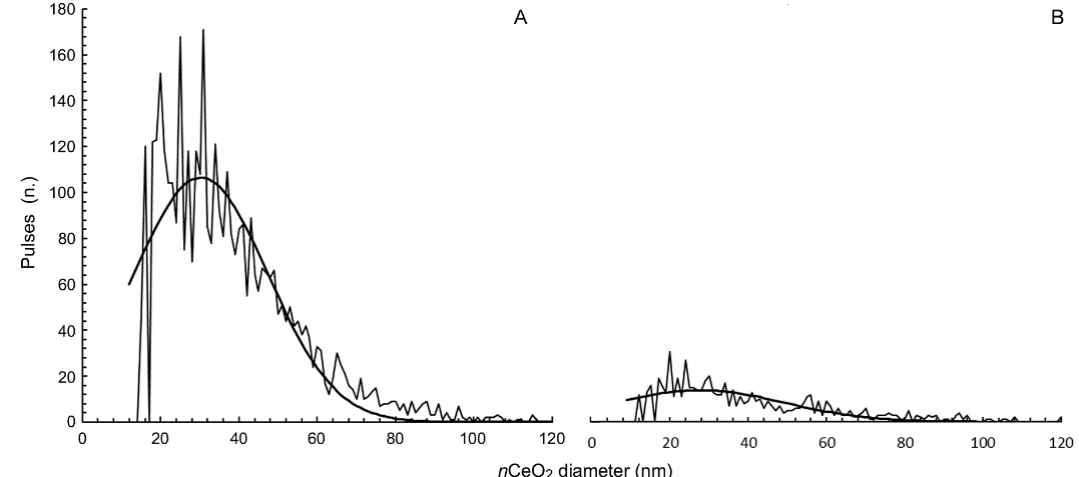
Figure 3. Particle size distribution of n CeO 2 extracted after enzymatic digestion procedure from ( A ) roots and ( B ) leaves of S. flos-cuculi .